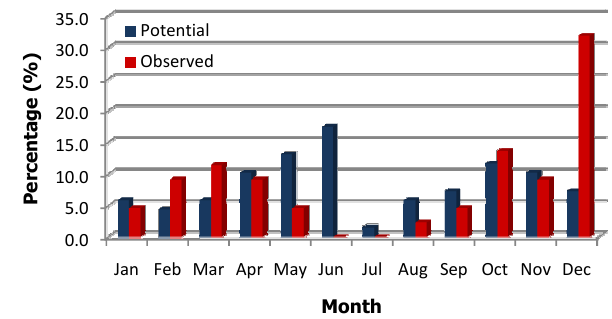
Fig. 8. The distribution of the values of the VGP index for the days where extreme (right) and non-extreme (left) events occurred.